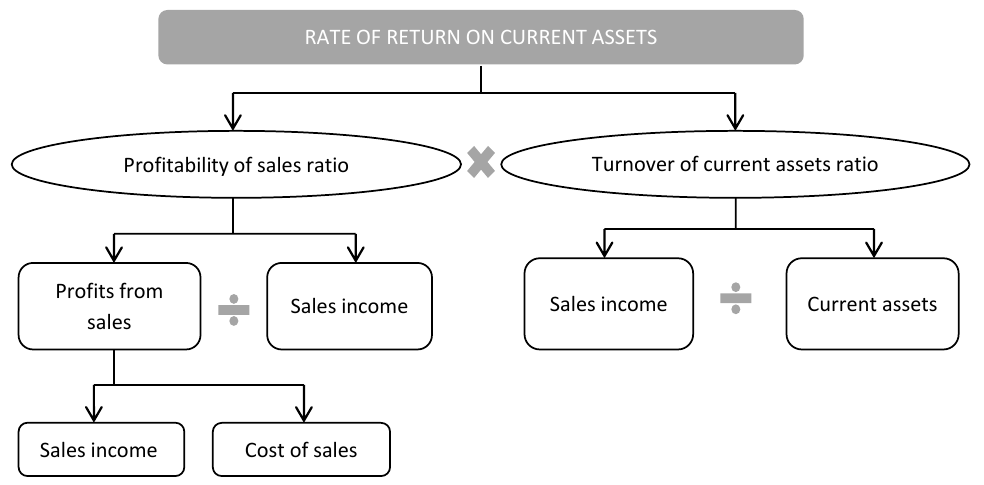
Figure 1. The structural and logical model of influence factors on the rate of return of current